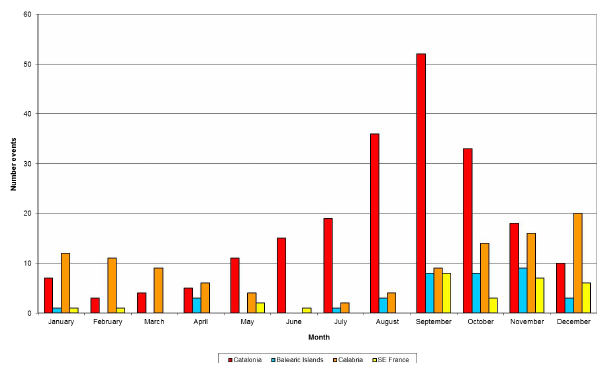
Fig. 2. Monthly distribution of flood events by category for the pe- riod 1981–2010, all the regions.